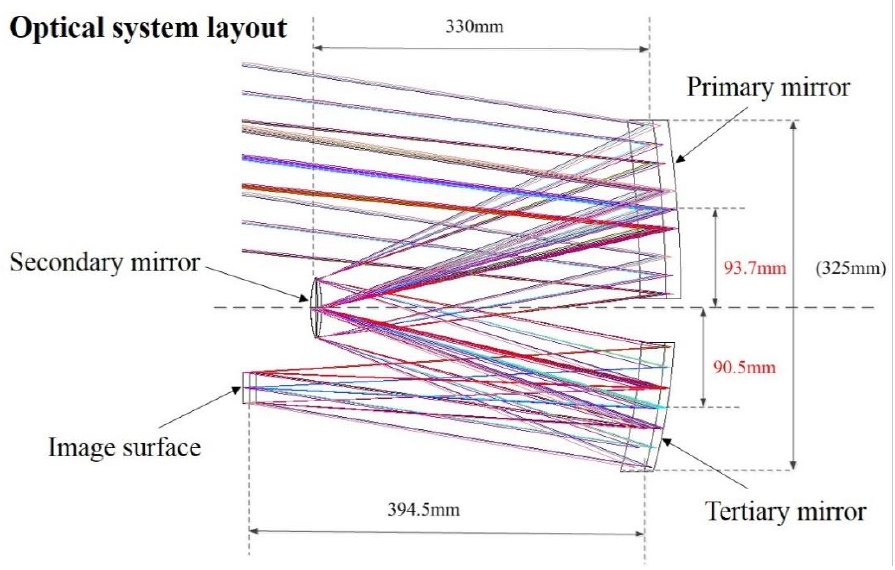
Figure 2. Optical layout of the camera.